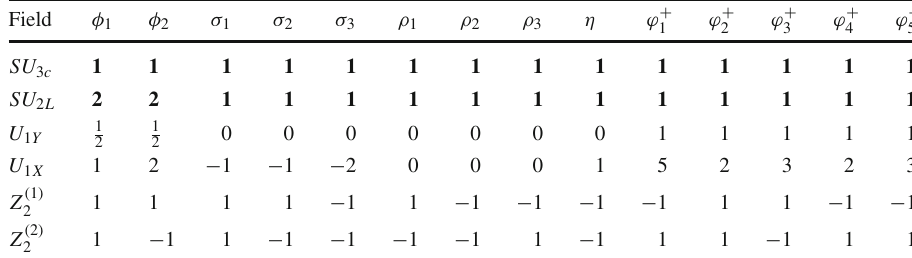
under the SU 3 c × SU 2 L × U 1 Y